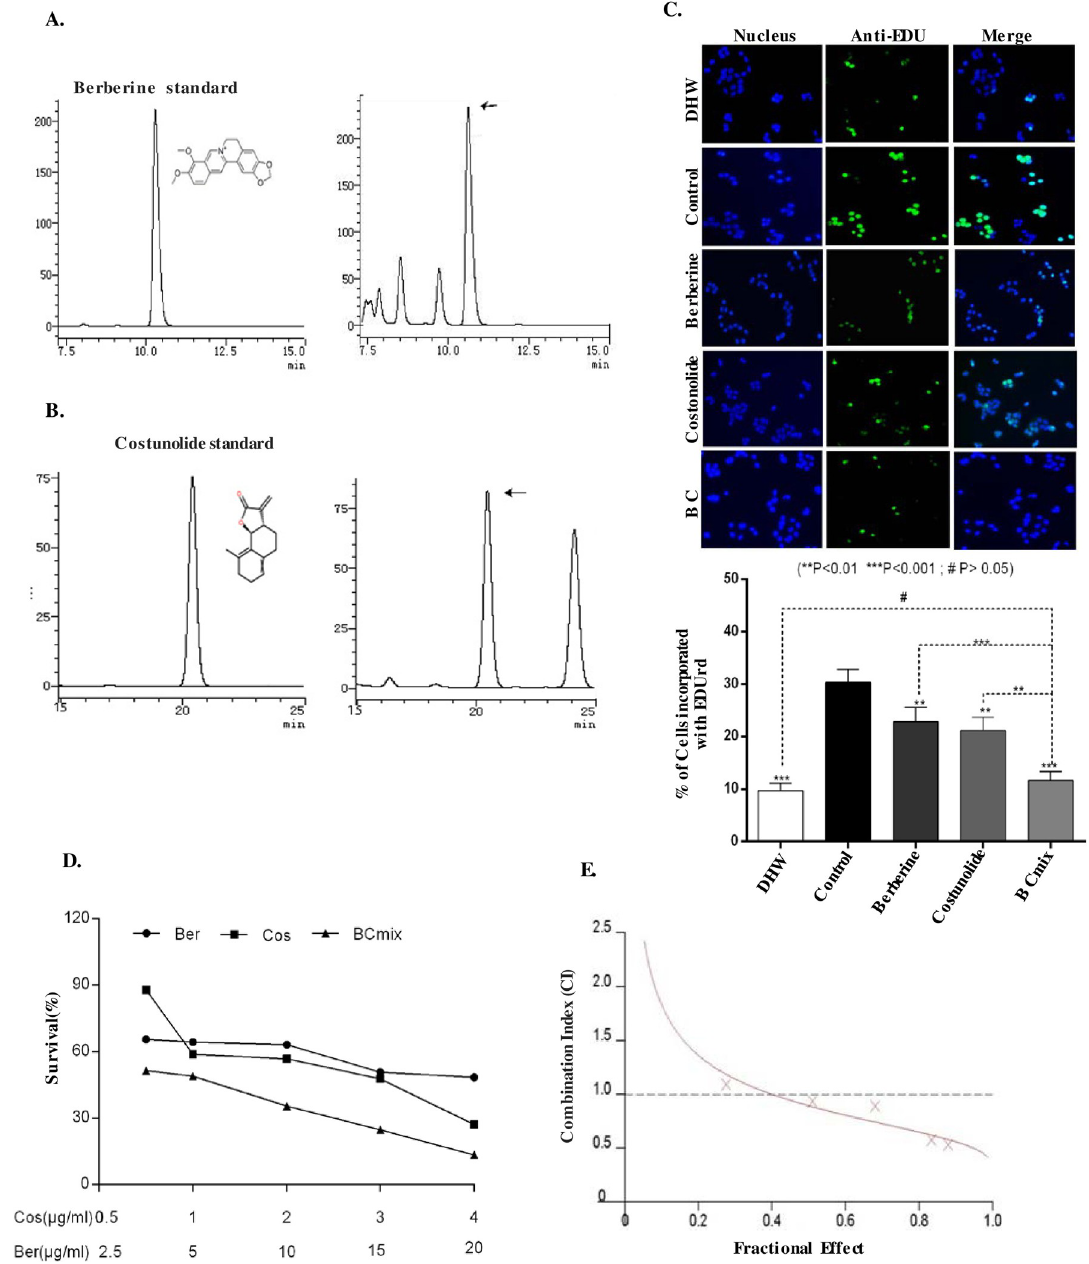
Fig 2. A, Panel 1 is the chromatogram and structure of Berberine standard; Panel 2 is the chromatogram of DHW samples; High performance liquid chromatograms. B, Panel 1 is the structure and chromatogram of Costunolide standard, Panel 2 is the chromatogram of DHW samples in different analysis. Arrows indicate the peaks representing Berberine or Costunolide; C, EdUrd incorporation assays were performed on PLC/PRF/5 cells treated with either DMSO (control), Berberine (2.5 μ g/ml) and/or Costunolide (0.5 μ g/ml), DHW extract (40 μ g/ml). The percentage of cells incorporating EDUrd after 48 hrs was shown. D, PLC/PRF/5 cells were treated with Berberine (Ber) and Costunolide(Cos) or both (BC mix) in a fixed ratio (5:1) for 48 hrs. Cell viability was measured by MTT assay. E, CI was calculated by isobologram analysis using the Chou-Talalay method. CI = 1, additive effect; CI < 1, synergistic effect; CI, > 1, antagonistic effect. Data represented are from three independent experiments.